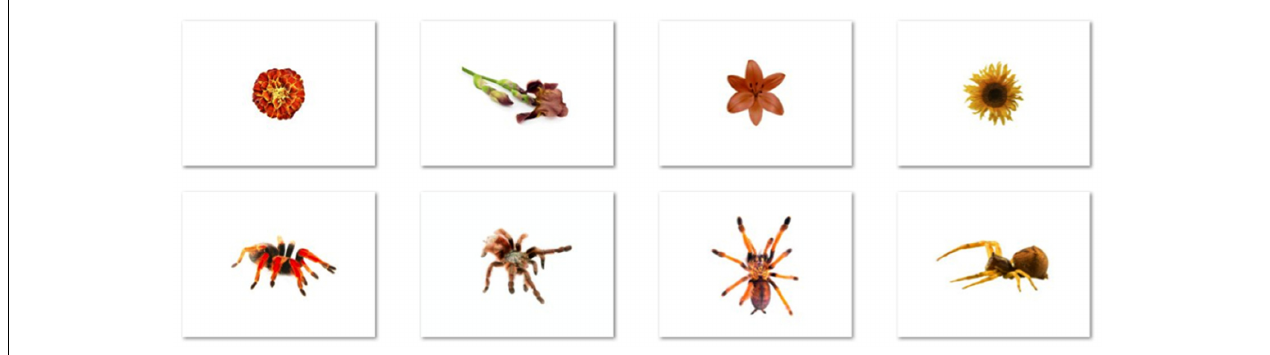
FIGURE 1 | Four pairs from the total of eight color-matched pairs of flowers (Top) and spiders (Bottom) used in Study 1. Each item from the spider category has a corresponding color-matched flower